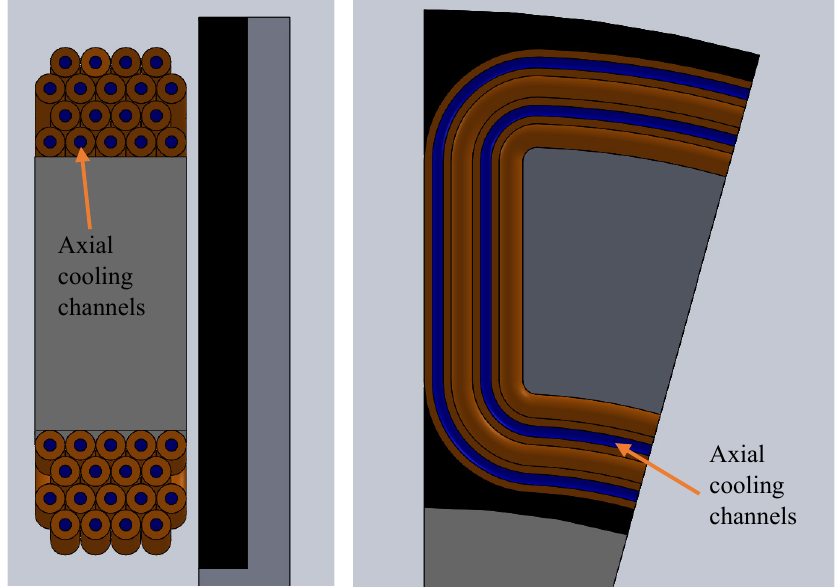
Figure 8. Illustration of intra-winding coaxial cooling paths within stator windings of an axial flux, permanent magnet